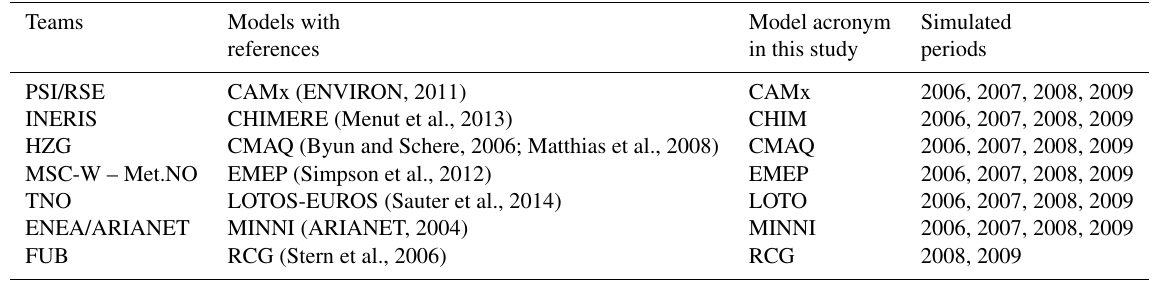
Table 1. Models involved in the study.